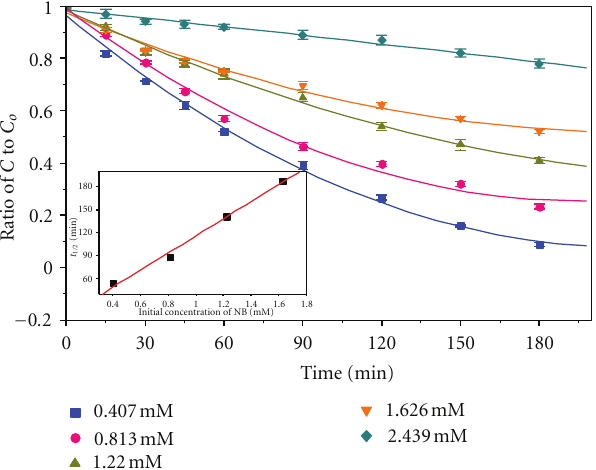
Figure 4: The initial concentration dependence of reaction rates for the photodegradation of nitrobenzene by TiO 2 as time changes. The processes were operated with 0.2 g TiO 2 and various concen- trations of nitrobenzene at pH 7 and 30 ◦ C with the air feeding of 150mLmin − 1 for 3h. Inset shows the e ff ect of the initial concentrations on the half-life of